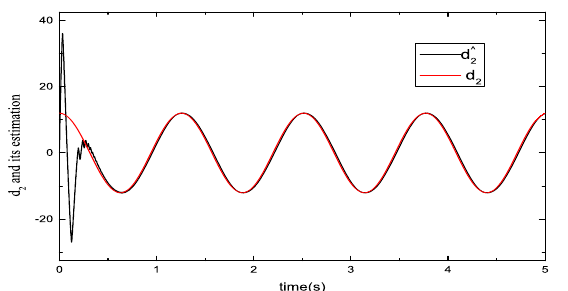
Figure 3. Performance evaluation curves for four unknown disturbance observers: disturbance of motor 2 and its estimated value.